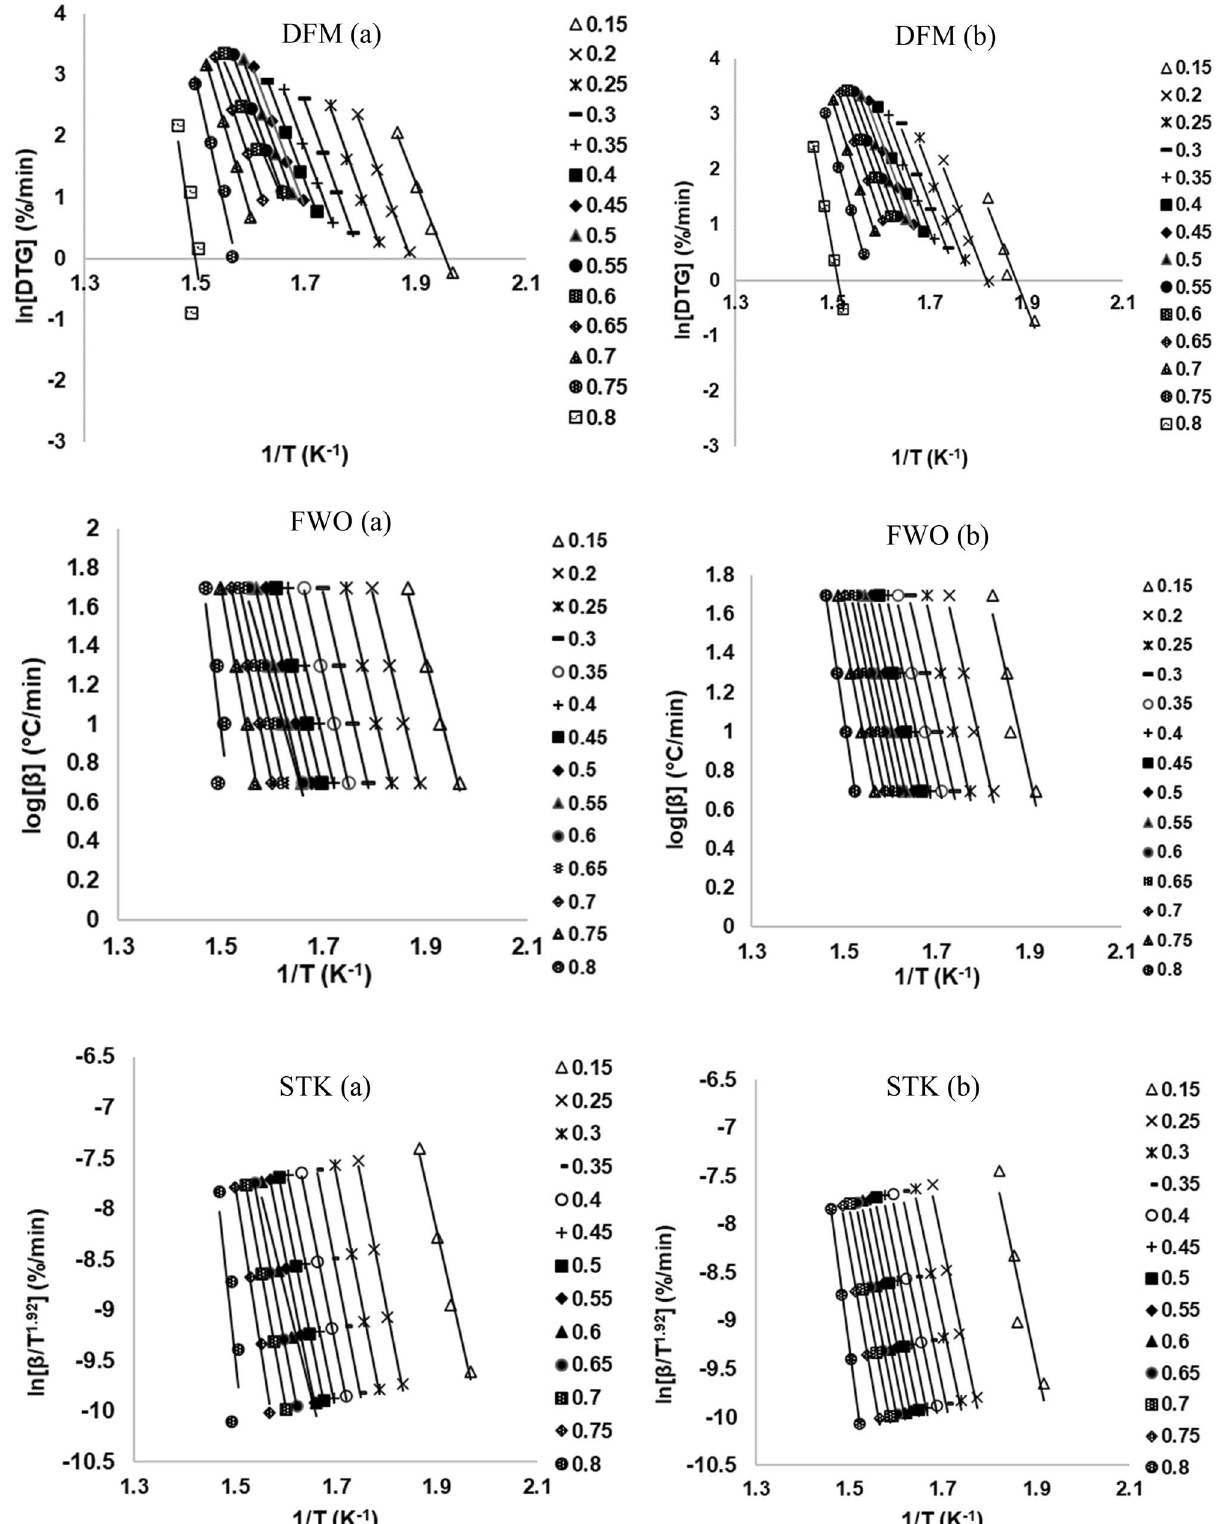
Figure 4. Graphs of iso-conversional lines of DFM, FWO, STK models for ( a ) MH and ( b ) RP in N 2 inert